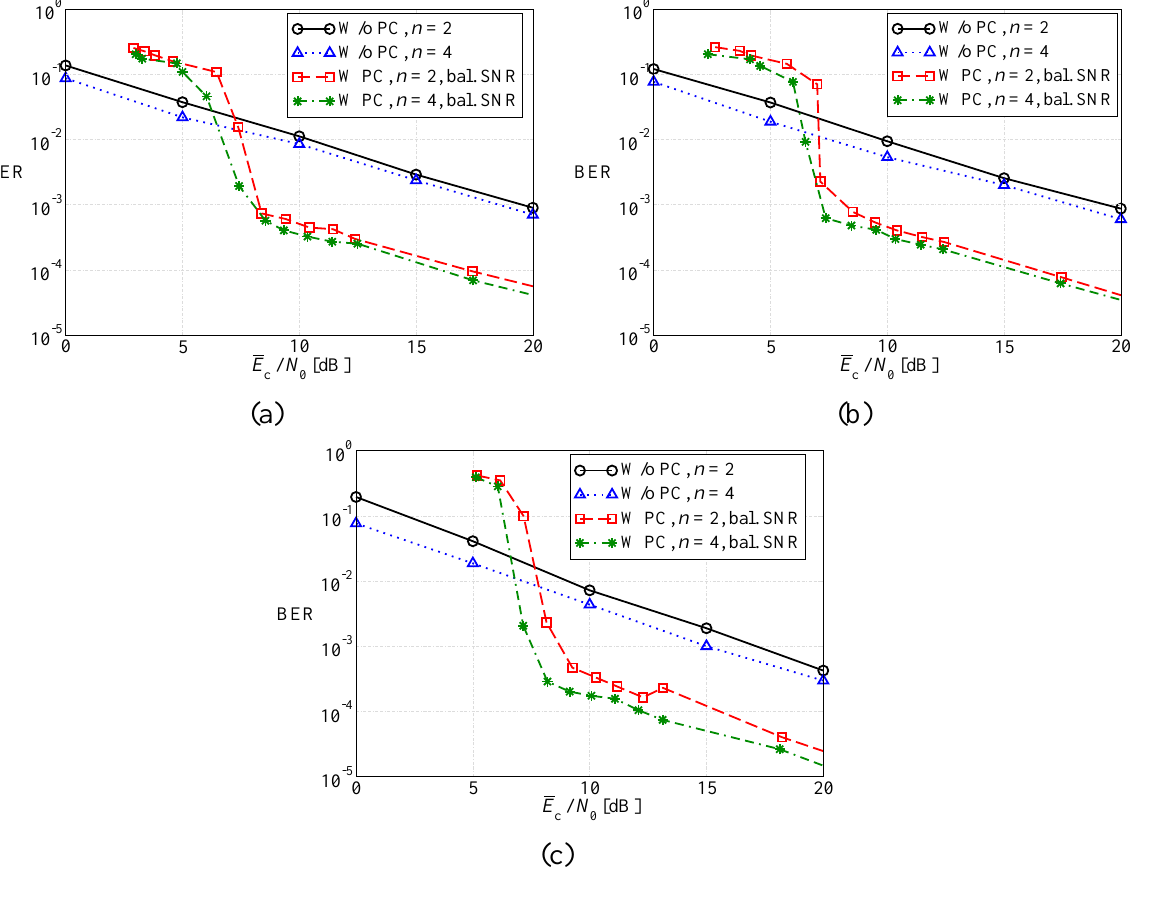
Figure 5. Average BER, as a function of the average SNR at the sources, considering: (a) regular LDPC-coded schemes, (b) DD LDPC-coded schemes, and (c) SCCCed